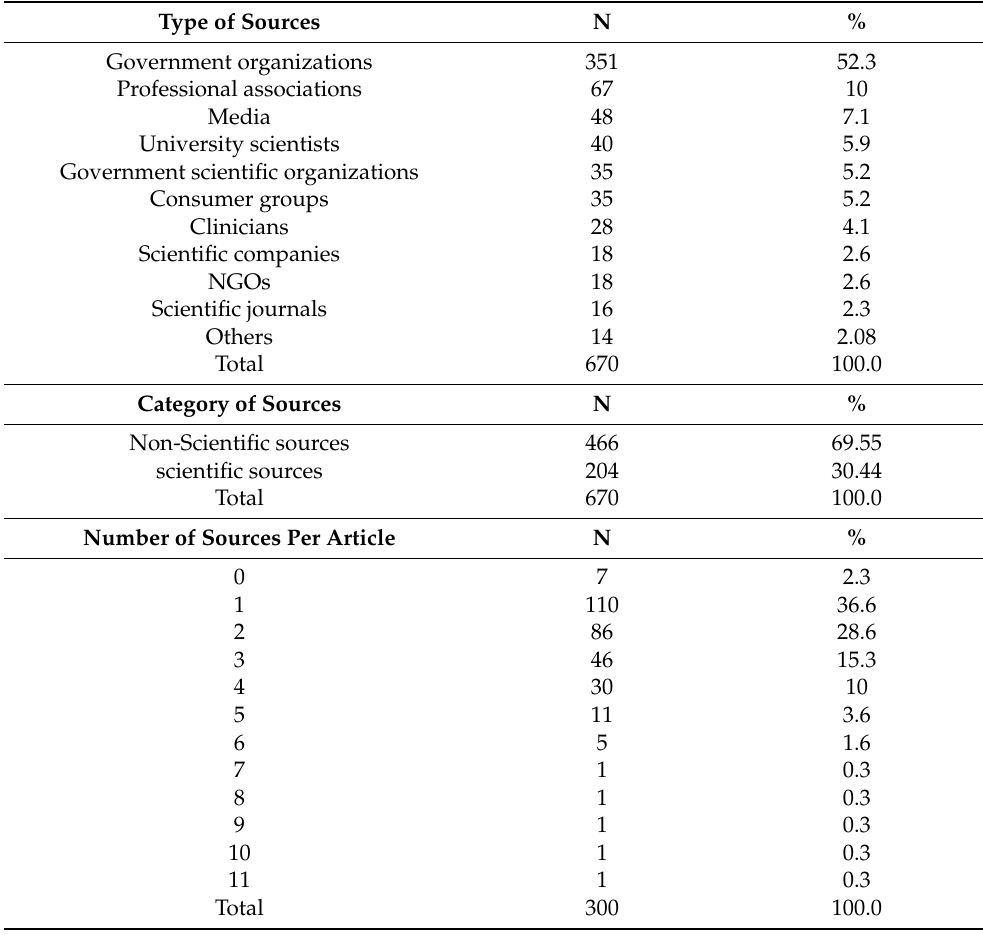
Table 2. Frequency counts for